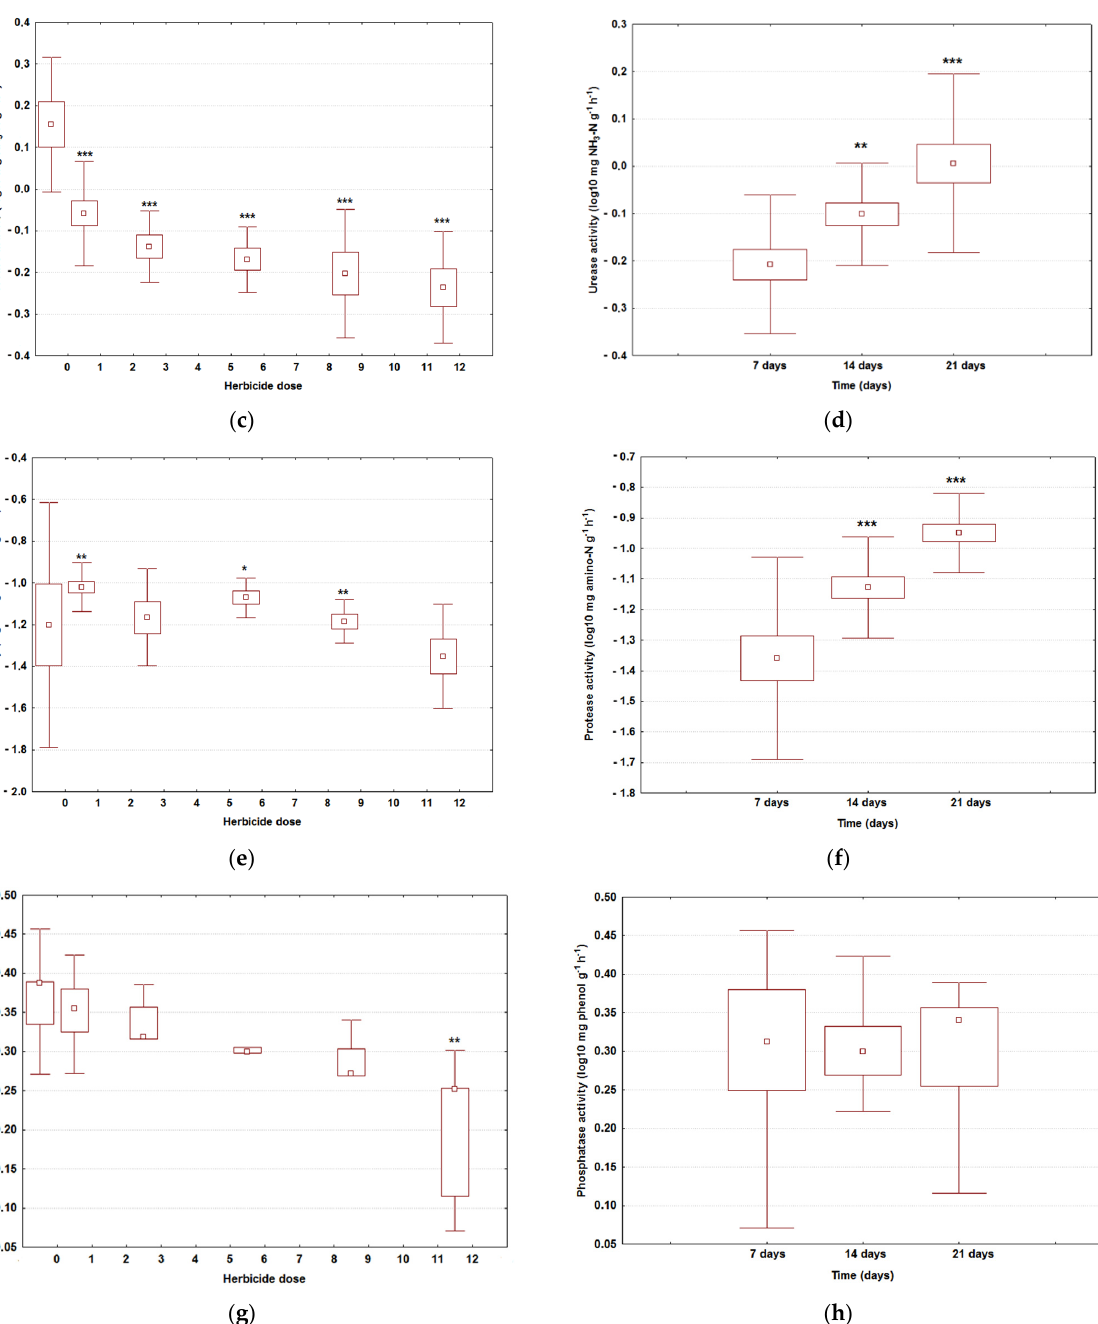
Figure 2. Evolution of enzymatic activities depending on the applied dose of S-metolachlor and on incubation time: dehydrogenase activity dependence on the dose of S-metolachlor ( a ) and on the incubation time ( b ); urease activity dependence on the dose of S-metolachlor ( c ) and on the incubation time ( d ); protease activity dependence on the dose of S-metolachlor ( e ) and on the incubation time ( f ); phosphatase activity dependence the dose of S-metolachlor ( g ) and on the incubation time ( h ). Parametric statistics was used to analyze data related to dehydrogenase activity, urease activity and protease activity, whereas nonparametric statistics was used for data related to phosphatase activity. The measured values for dehydrogenase activity, urease activity and protease activity are shown on log 10 scale as mean (point) with one standard error (box) and one standard deviation (error bar). The measured values for phosphatase activity are shown on log 10 scale as median (point) with lower and upper quartiles (box) and minimum and maximum values (error bar). Marked boxes (*) indicate significant differences as compared to the reference group (for dehydrogenase activity, urease activity and protease activity: Tukey’s HSD test, *** p < 0.001, ** p < 0.01, * p < 0.05; for phosphatase activity: Dunn’s test, *** p < 0.001, ** p < 0.01, * p <